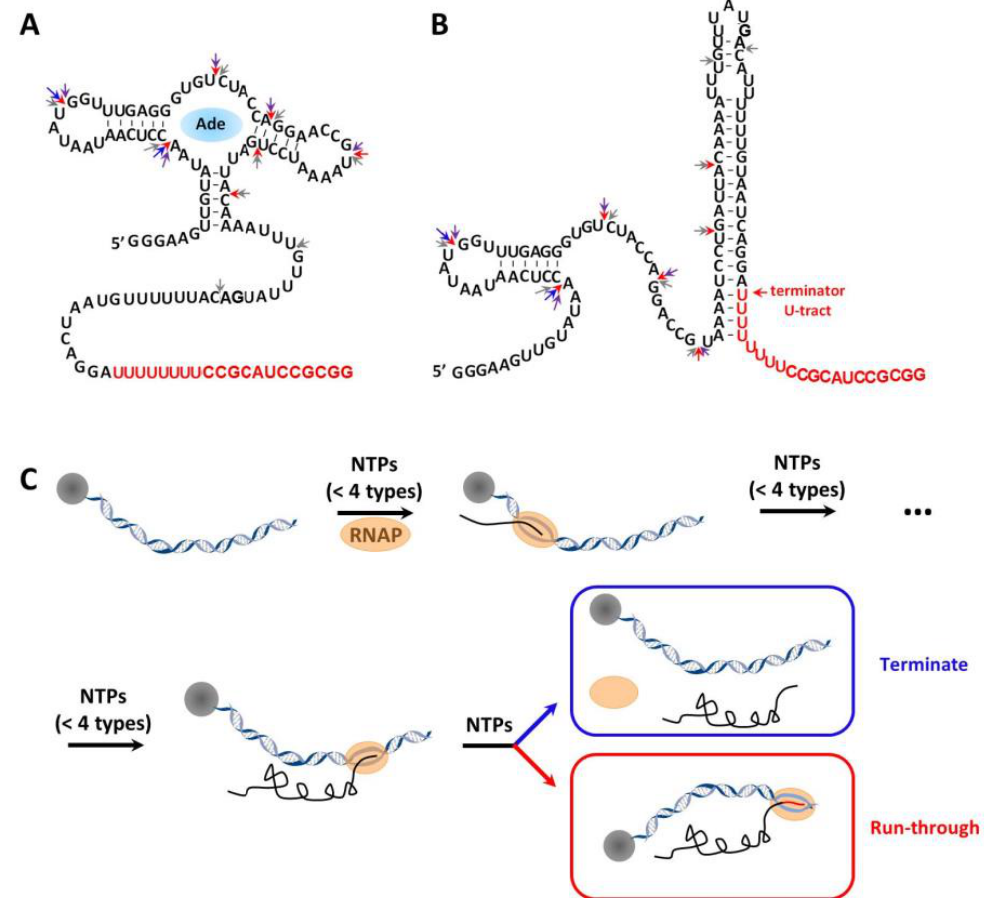
Figure 1. Schematic illustration of quantifying transcription termination of adenine riboswitch RNA via PLOR. ( A , B ) The secondary structures of adenine riboswitch RNA in the presence ( A ) and absence of adenine ( B ). Adenine is shown as a blue ball. The nucleotides in the terminator U-tract are shown in red. The pause positions at 3-step, 6-step, 8-step and 10-step PLOR reactions are marked by blue, purple, red and grey arrows, respectively. ( C ) The solid–liquid hybrid phase transcription in PLOR is divided into multiple steps by omitting certain types of NTPs. The 5 (cid:48) biotin-labeled DNA templates (grey ribbons) are immobilized on streptavidin-coated agarose beads (grey beads). The RNAP and nascent RNA are shown by orange spheres and black lines, respectively. When RNAP proceeds along the terminator sequence, RNAP either dissociates from DNA and produces the terminated products (in blue box) or RNAP continues transcription to produce full-length RNA products (in red box).